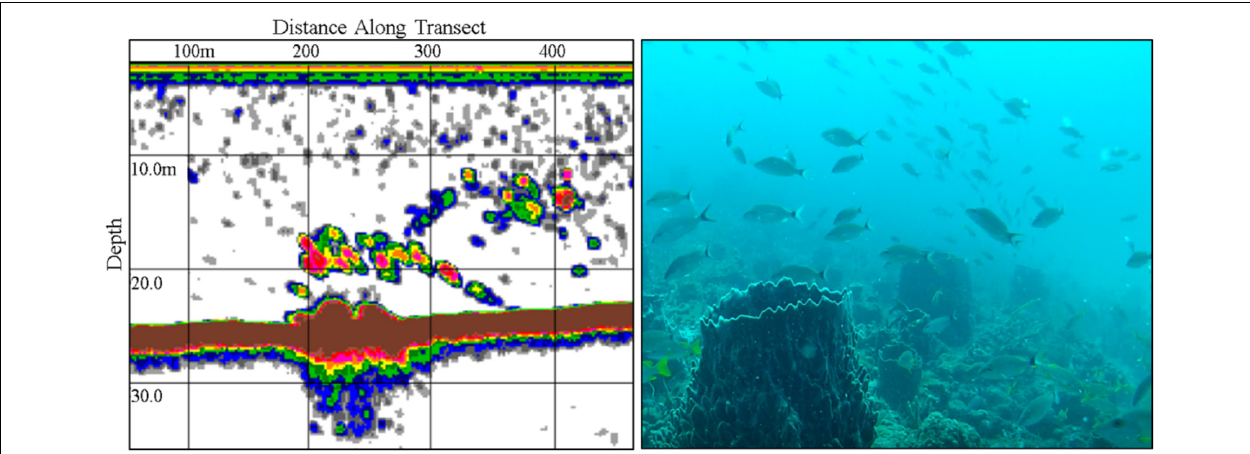
FIGURE 5 | Echosounder surveys were conducted on a historically recognized gag grouper aggregation site east of Boynton Beach, Florida ( left ). Unbaited remote underwater video (URUV) tripods were deployed ( right ) where elevated backscatter was observed in echosounder surveys, to determine species identity and abundance, though no evidence of aggregating gag grouper was observed. Schools consisted of a mixed assemblage of reef fish, dominated by dense schools of tomtates (Haemulon